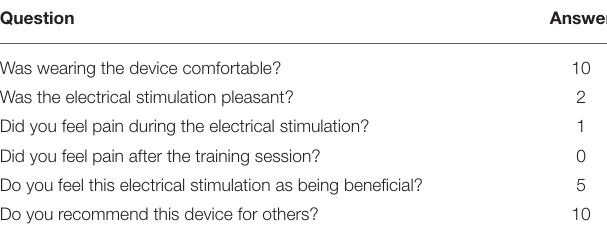
TABLE 3 | The patient’s perspective: questionaire answered by the patient. Question